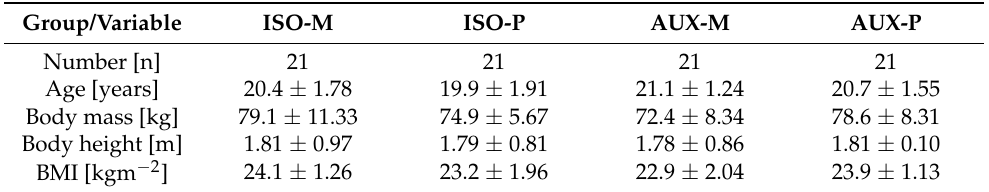
Table 1. Characteristics of study participants by group.